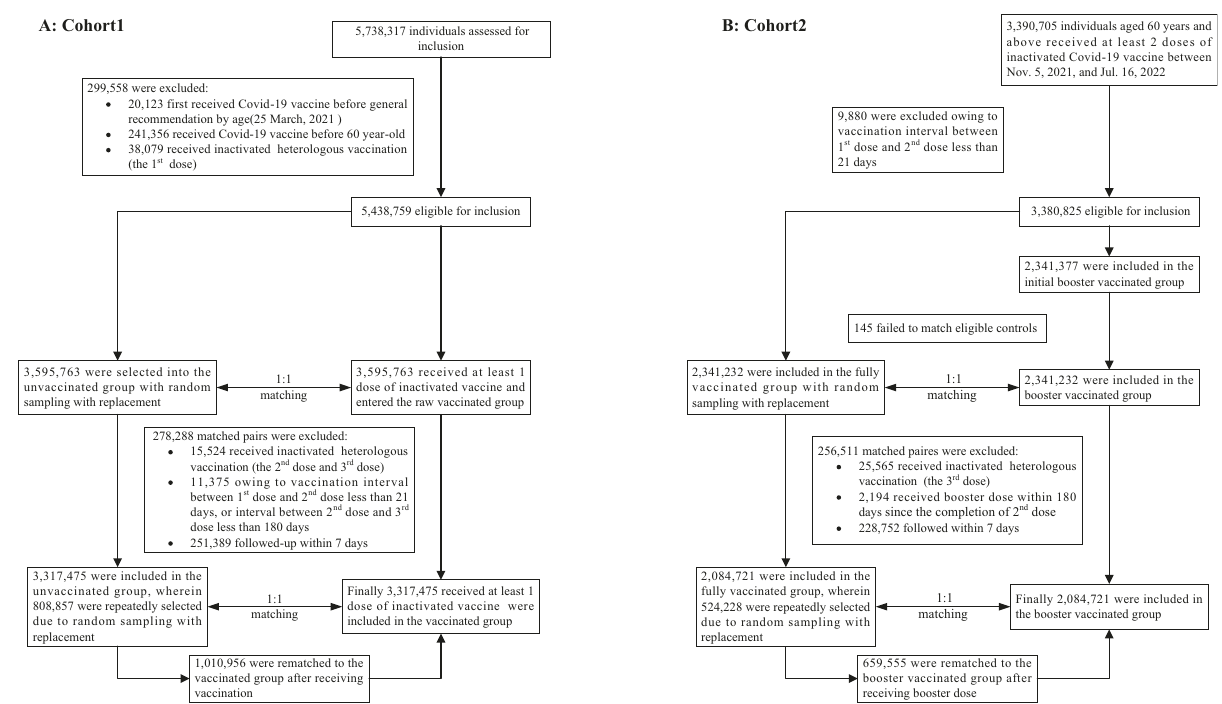
Fig. 2 | Cohort enrollment process. Cohort selection for the analysis of effectiveness of vaccination with inactivated vaccine ( A: Cohort 1) and booster vaccination with inactivated vaccine ( B: Cohort